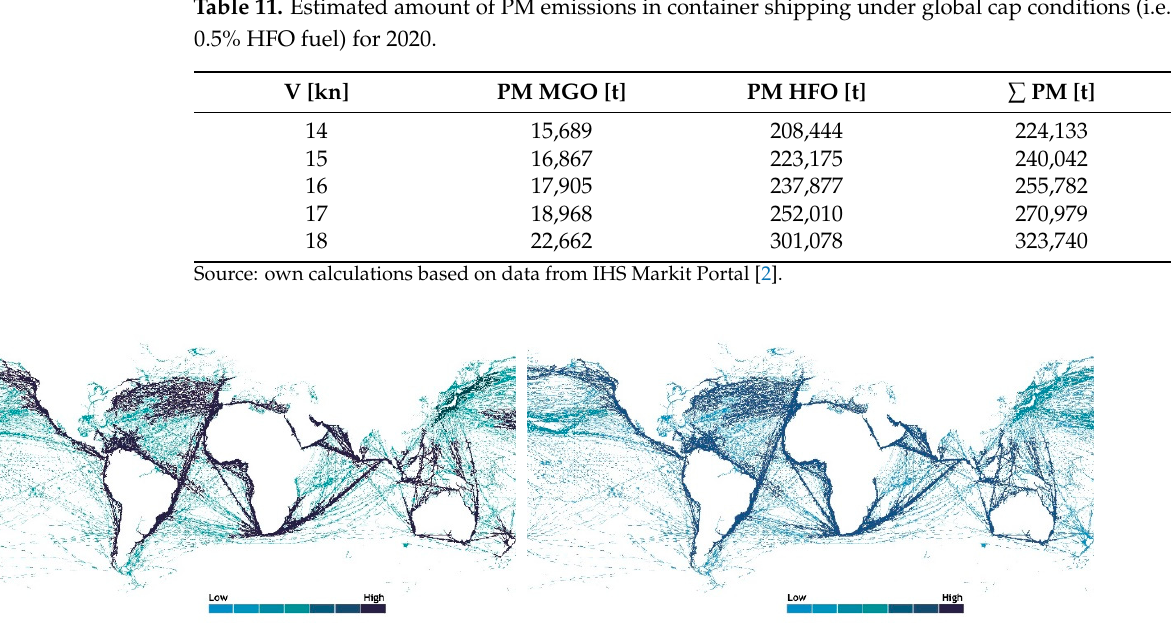
Figure 6. Annual global container shipping PM emission levels for 2020, (left) base situation for 2018 and (right) estimates using the energy consumption approach, based on extrapolated data from IHS Markit Portal [2].